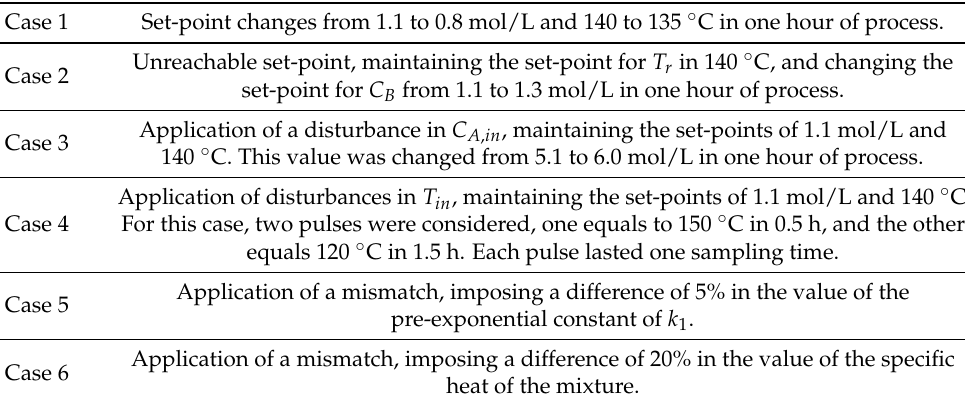
Table 3. Cases considered to analyze the different approaches